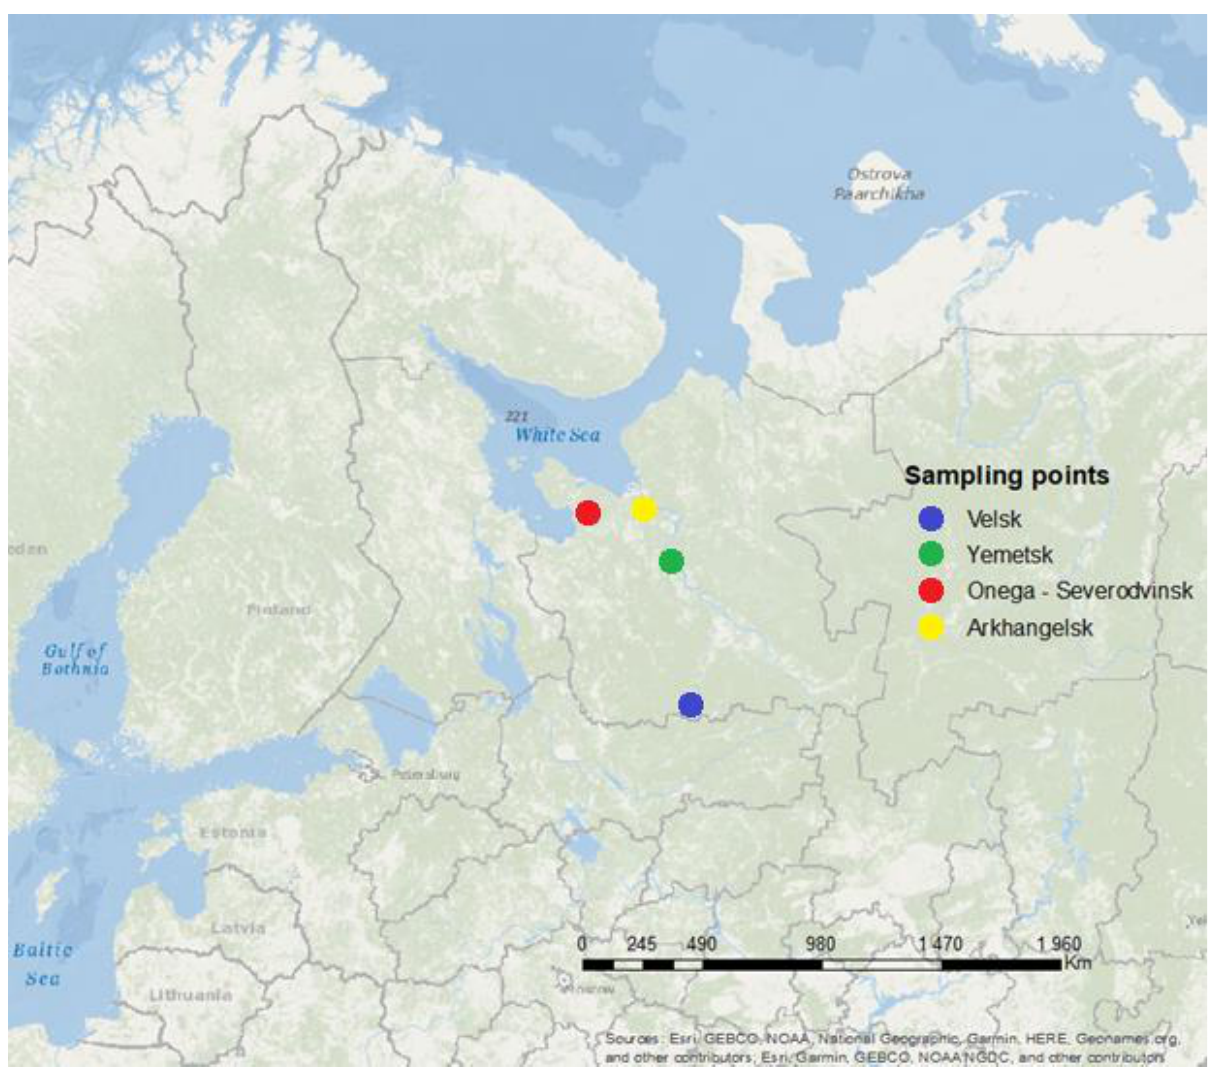
Figure 1. Locations of the four sampling points within the Arkhangelsk region of